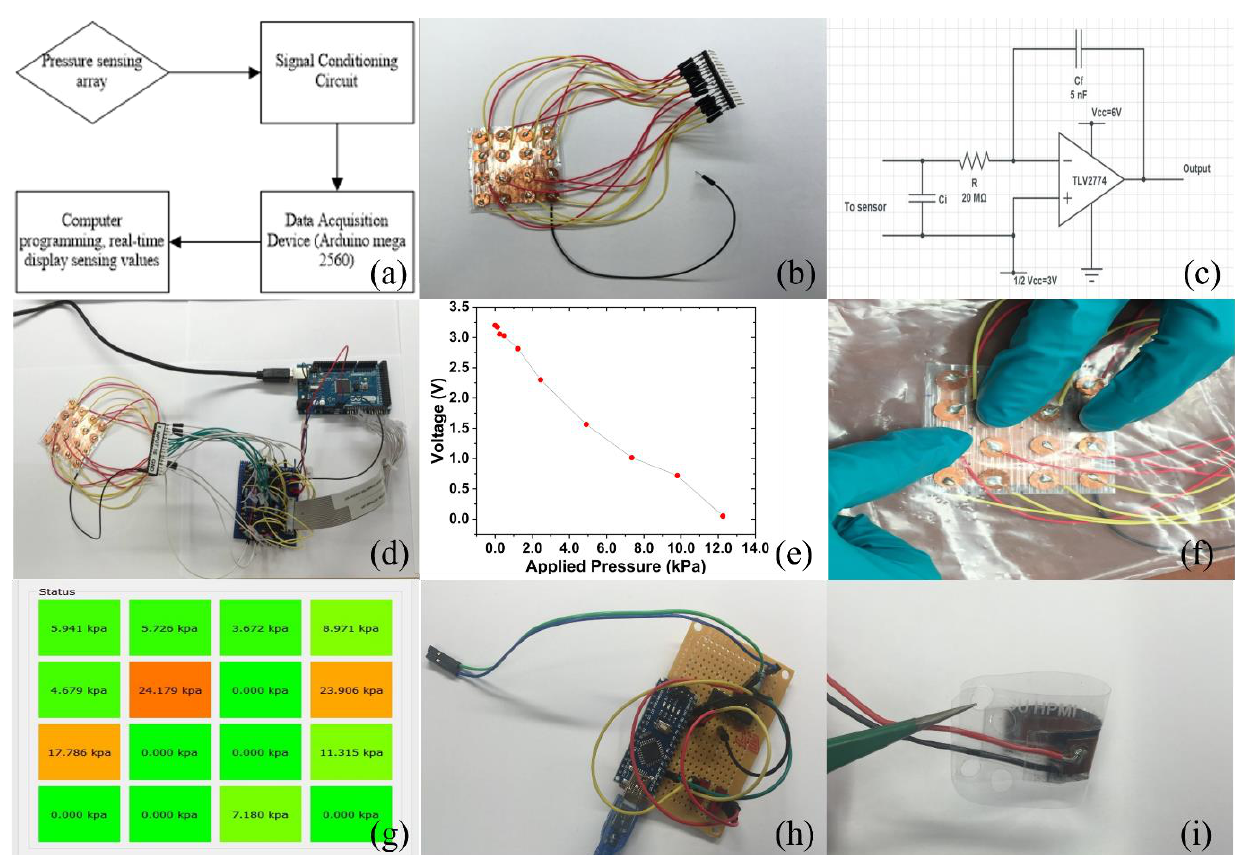
Figure 4. ( a ). Illustration of design of the pressure-sensing and mapping device based on COC piezoelectric materials; ( b ). Piezoelectric sensor signal-conditioning circuit converts high-impedance signals to low-impedance signals; ( c ). Voltage–pressure relationship of COC piezoelectric foam as the pressure-sensing result; ( d ). Photograph of the piezoelectric foam sensor array with 4 × 4 sensor for demonstration purposes; ( e ). Layout of the multipoint pressure-sensing device based on COC piezoelectric materials; ( f , g ). Demonstration of multi-point tactile-sensing capability of the material; ( h ). Demonstration of the capability of piezoelectric foam as flexible biosignal-measuring sensor; ( i ). A compact design of the sensing circuit demonstrated the wearable, low-cost, low-power-consumption pressure-sensing capability of the piezoelectric foam.